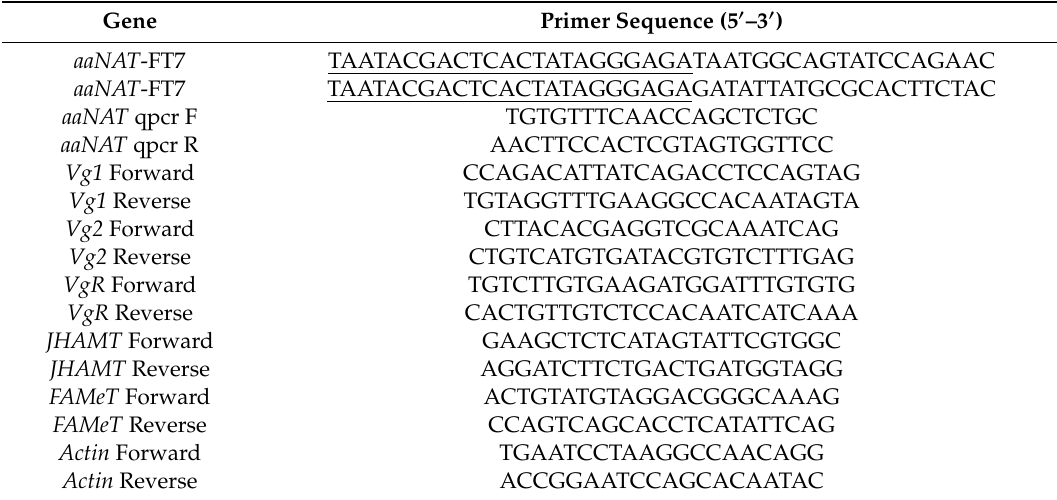
Table 1. A list of primers used in the experiments.